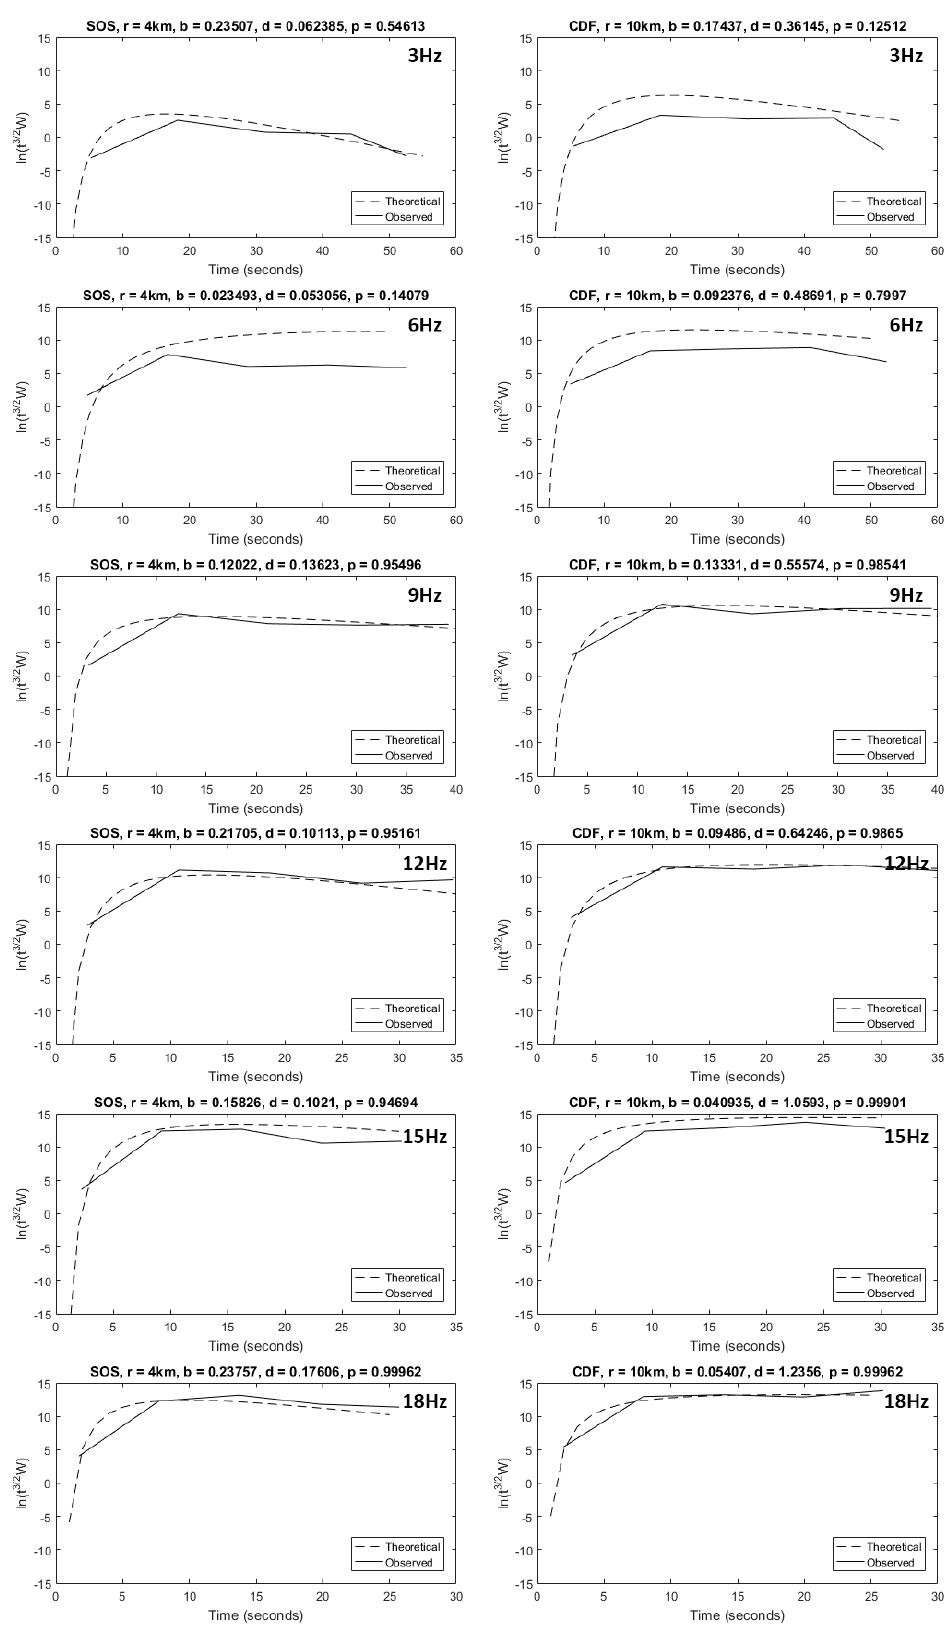
Figure 8. Theoretical (dashed) vs. observed (solid) measurements for the logarithm of the averaged seismic energy density as corrected for geometrical spreading of body waves. By varying frequency the data fit can change quite drastically.